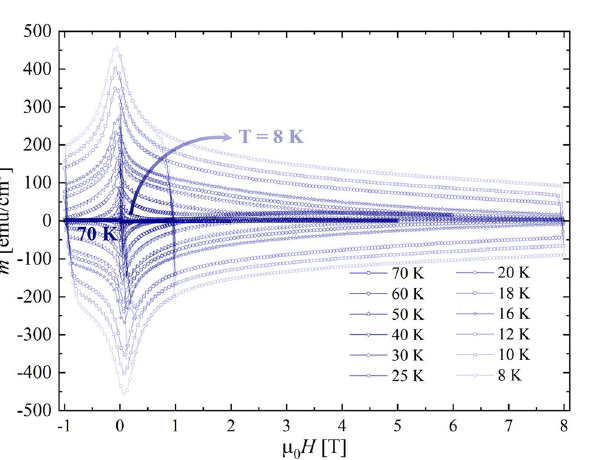
Figure 3. Magnetisation as a function of the applied magnetic field, up to 8 T, recorded at 70, 60, 50, 40, 30, 25, 20, 16, 12, 10 and 8